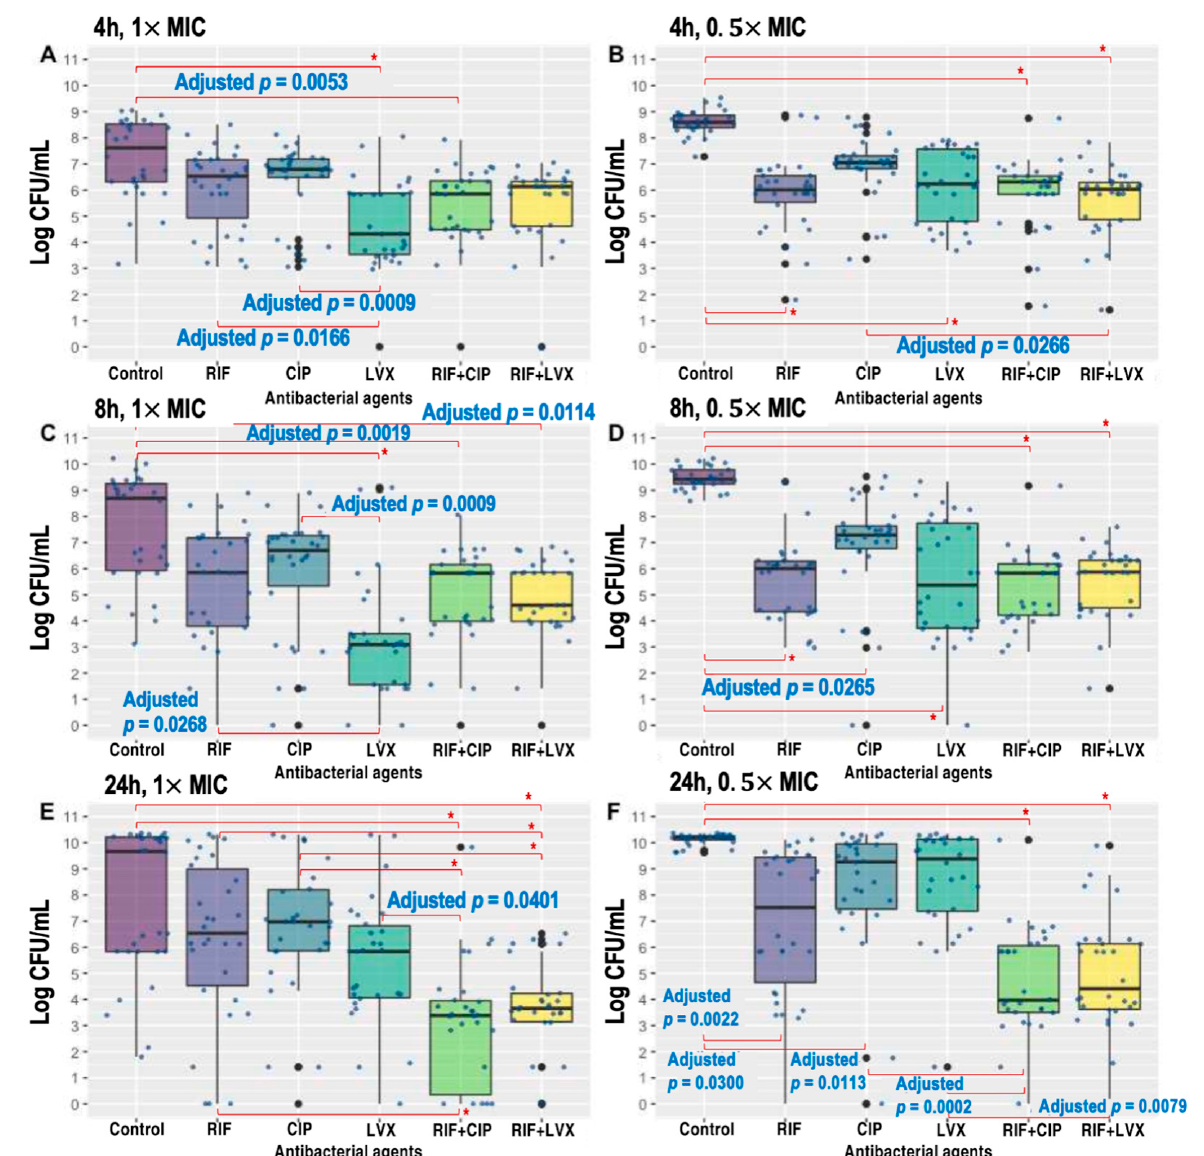
Figure 3. Comparison of viable bacterial counts after exposure to different antibacterial agents for a speci fi c time period. * Adjusted p < 0.0001. ( A ) Changes in viable bacterial counts following a 4-h exposure to antibacterial agents at a concentration equal to 1× minimum inhibitory concentration (MIC). ( B ) Changes in viable bacterial counts following a 4-h exposure to antibacterial agents at a concentration equal to 0.5× minimum inhibitory concentration (MIC). ( C ) Changes in viable bacte- rial counts following a 8-h exposure to antibacterial agents at a concentration equal to 1× minimum inhibitory concentration (MIC). ( D ) Changes in viable bacterial counts following a 8-h exposure to antibacterial agents at a concentration equal to 0.5× minimum inhibitory concentration (MIC). ( E ) Changes in viable bacterial counts following a 24-h exposure to antibacterial agents at a concentra- tion equal to 1× minimum inhibitory concentration (MIC). ( F ) Changes in viable bacterial counts following a 24-h exposure to antibacterial agents at a concentration equal to 0.5× minimum inhibi- tory concentration (MIC).